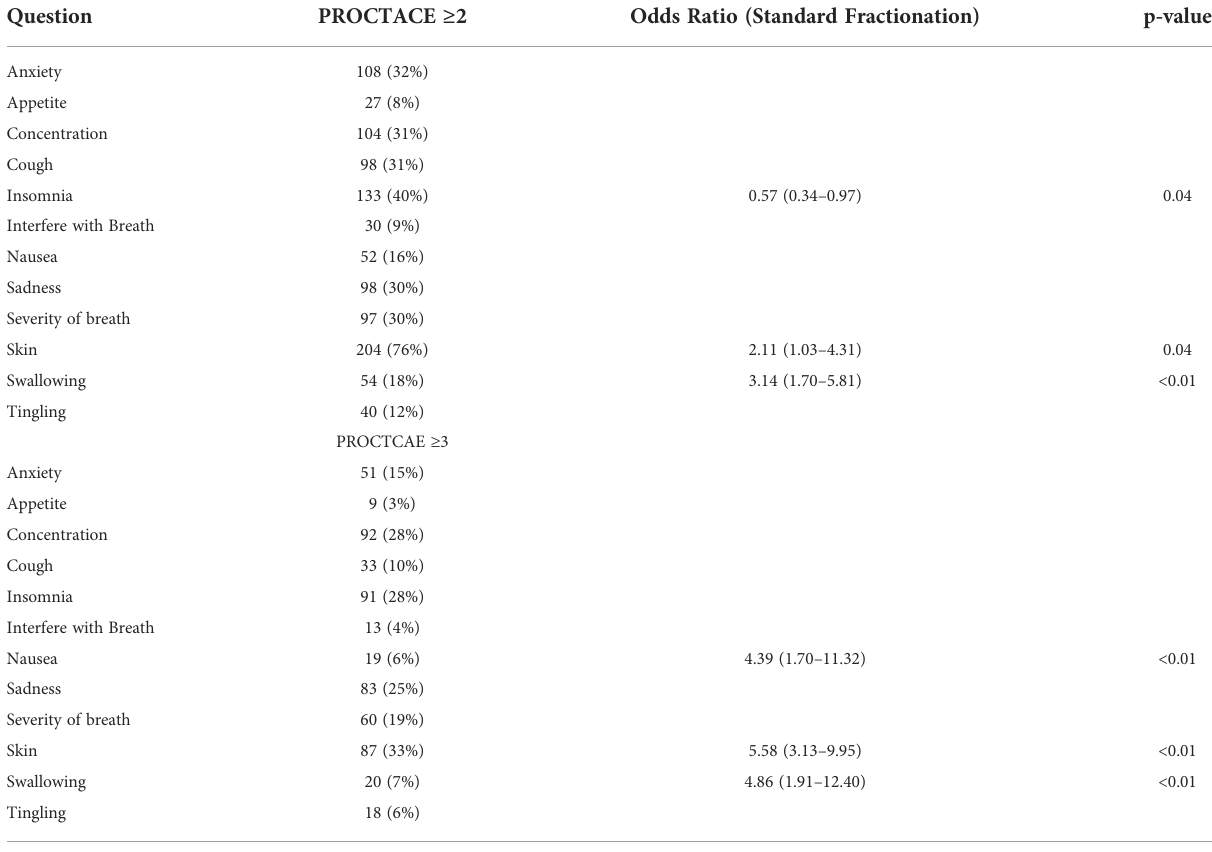
TABLE 4 PRO-CTCAE ≥ 2 and ≥ 3 by individual items.